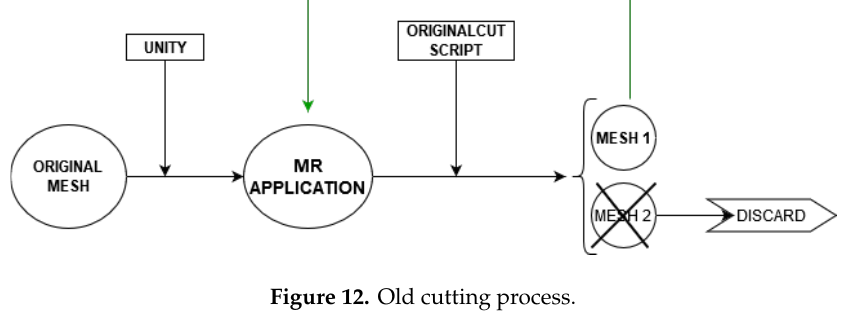
Figure 12. Old cutting process.